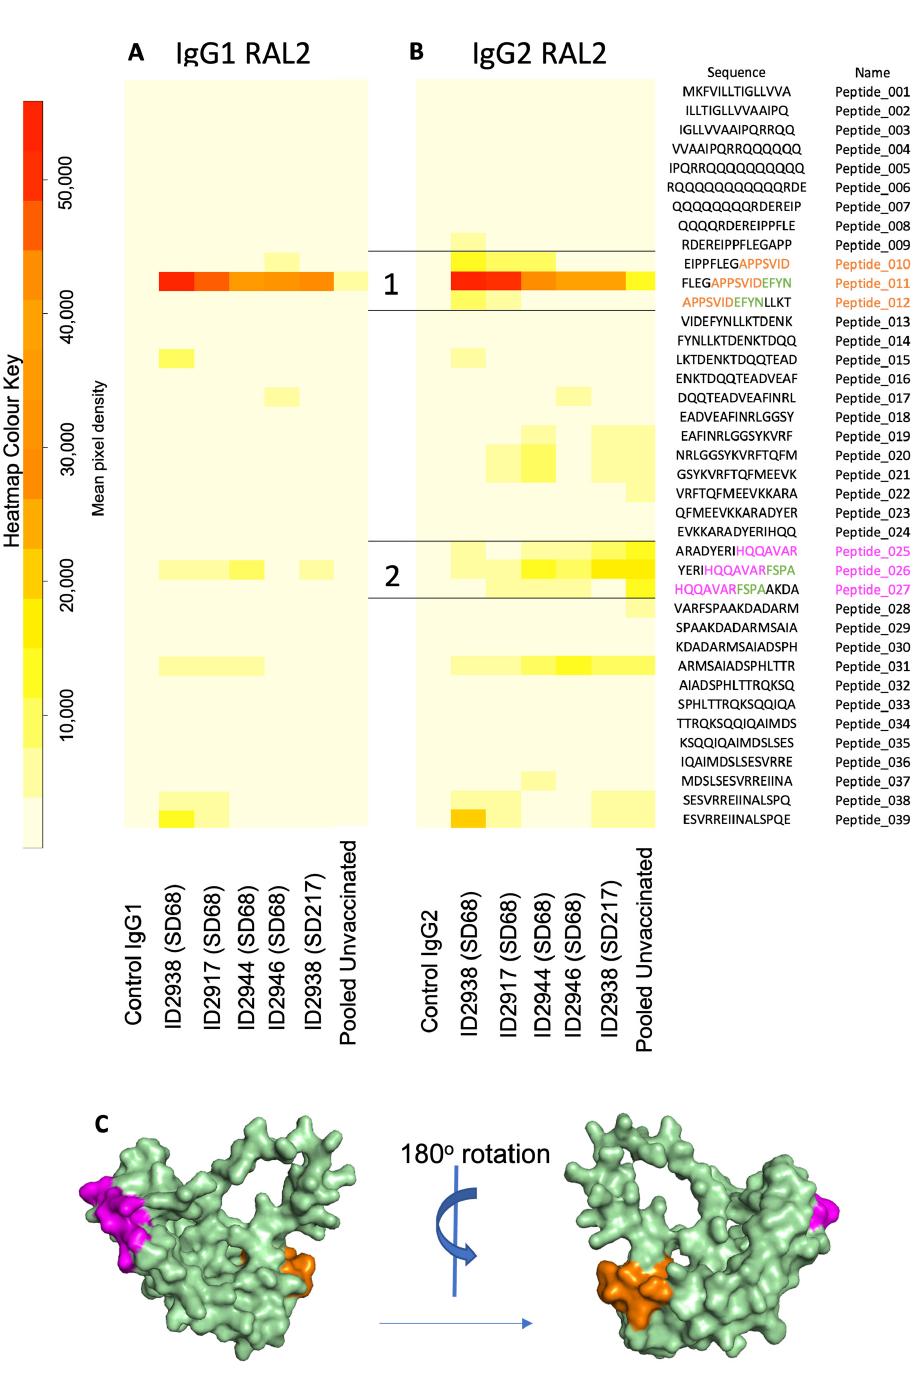
Figure 6. Peptide array heatmaps for IgG purified from IgG of animals vaccinated against Ov -RAL-2. Whole protein sequence divided into 39 overlapping peptides sequences 15 amino acids in length. Intensity of colour (white to red) shows degree of host antibody recognition (represented by mean pixel density) to ( A ) IgG1 and ( B ) IgG2. IgG controls (provided by JPT, lane 1) and anti-bovine IgG pooled from three unvaccinated, uninfected calves (lane 7) was included on each array, with purified serum IgG from individual vaccinated animals at one-week post-booster (SD62; 2938, 2917, 2944, 2946, lanes 2–5) and a single animal at 4 months post-exposure (SD215; 2938, lane 6). Putative epitopes recognised by IgG from vaccinated animals (1 and 2) were mapped onto a 3D model of Ov -RAL-2 using Alphafold2 [36] ( C ); Epitope 1 in orange and epitope 2 in